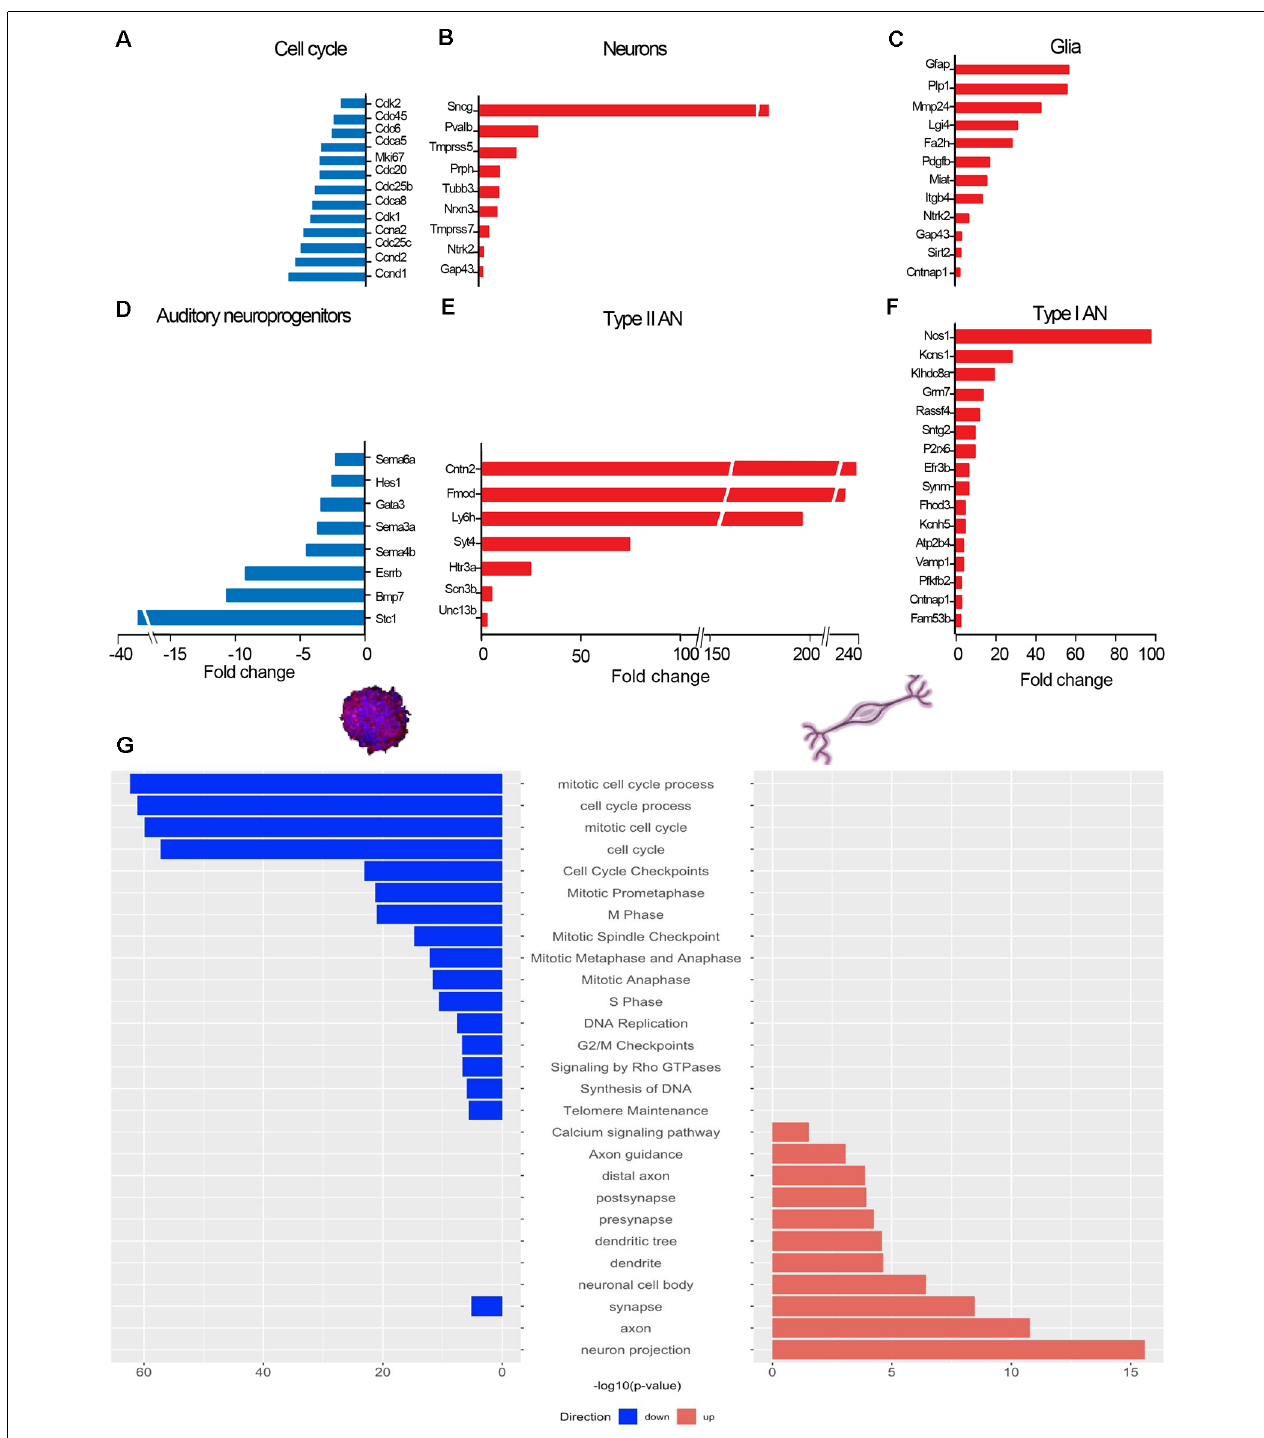
FIGURE 4 | Changes in gene expression upon differentiation. RNAseq-based transcriptome analysis of phoenix auditory neurons (D7 differentiation). mRNA levels in differentiated cells are expressed relatively to neuroprogenitor spheres of equivalent passage (samples were paired at passage 12, 21, and 36 forming a triplicate). (A–F) Bar graphs showing changes in expression of main genes related to (A) cell cycle, (B) neural differentiation, (C) glial differentiation, (D) neuroprogenitor markers, (E) type II auditory neurons, and (F) type I auditory neuron in differentiated phoenix auditory neurons relatively to neuroprogenitors spheres. All genes showed in the bar graphs were significantly differentially expressed (FDR < 0.05). (G) Main relevant gene ontologies showing a significantly different level in mature neurons (red) vs. neuroprogenitors (blue). Results are representative of the average from triplicates of cells originating from three different litters.